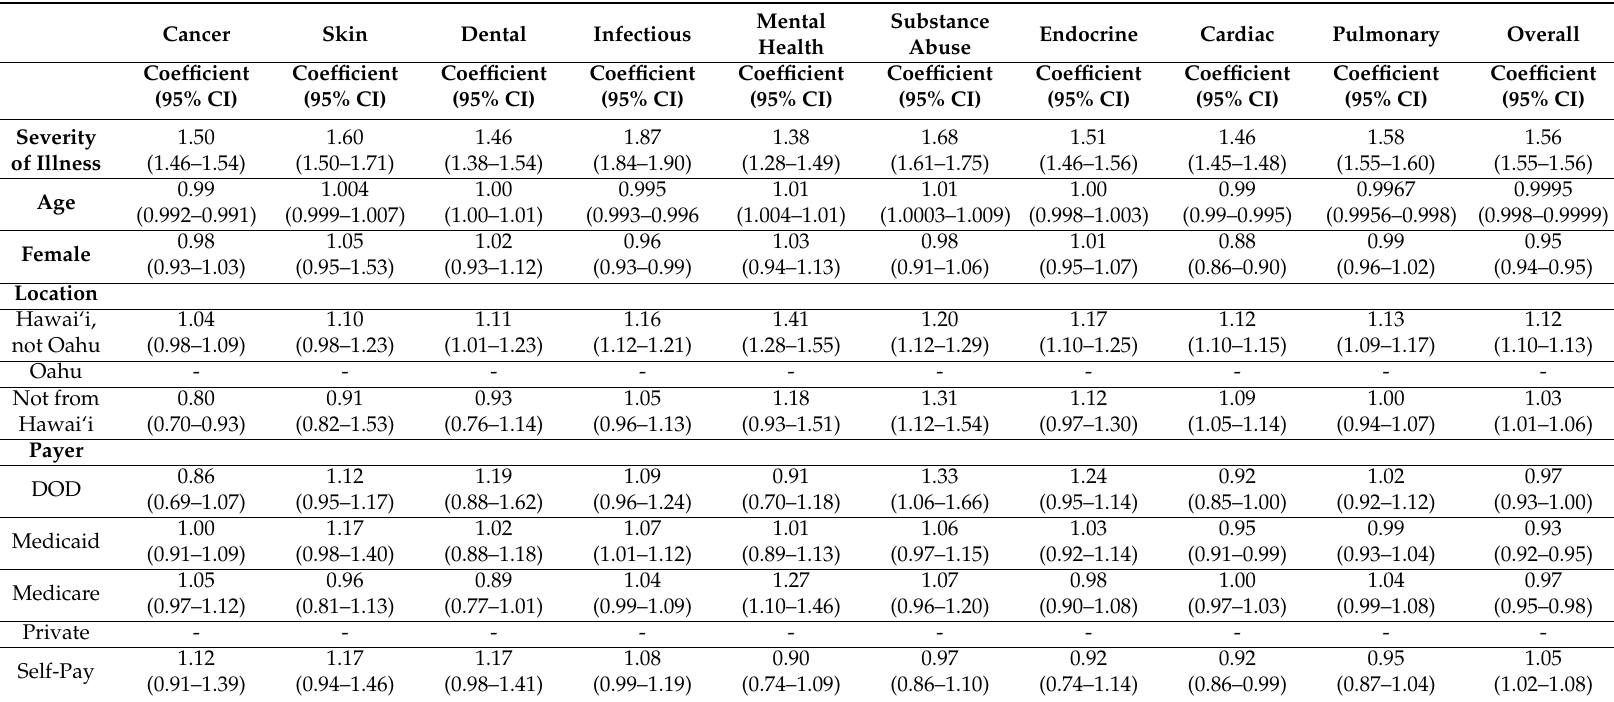
Table A3. Significant Variables in Multivariable Models with Severity of Illness